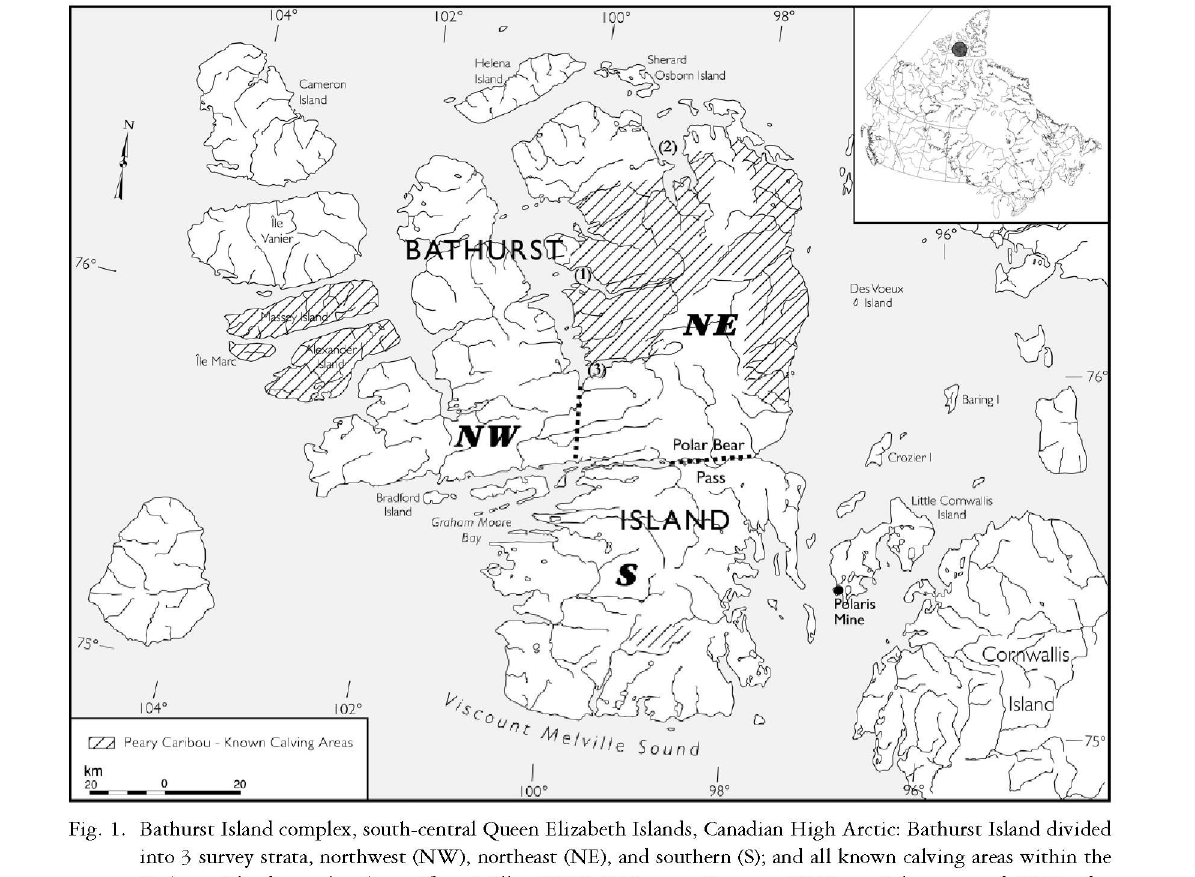
Fig. 1. Bathurst Island complex, south-central Queen Elizabeth Islands, Canadian High Arctic: Bathurst Island divided into 3 survey strata, northwest (NW), northeast (NE), and southern (S); and all known calving areas within the Bathurst Island complex shown (from Miller, 2002): (1) Stewart Bay area; (2) Young Inlet area; and (3) Dundee Bight area on Bathurst Island, plus Alexander and Massey islands to the west of Bathurst